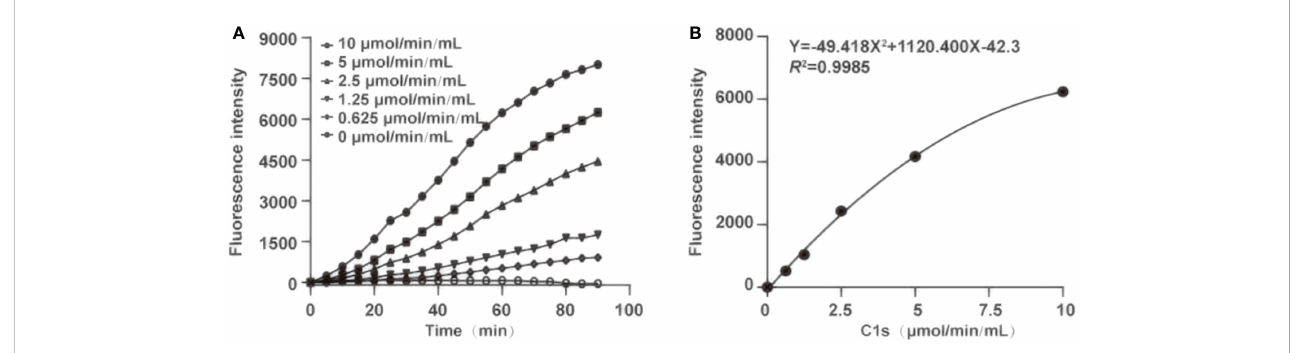
FIGURE 3 Optimization of the reaction time and generation of standard curve. (A) The optimum reaction time was ascertained in the presence of chromogenic peptide 3 (10 m L, 1 m g/mL). Fluorescence intensity was recorded at the indicated time; (B) Plot of standard curves were generated against activated C1s with different concentrations (0.625, 1.25, 2.5, 5, and 10 m mol·min -1 ·mL -1 ).